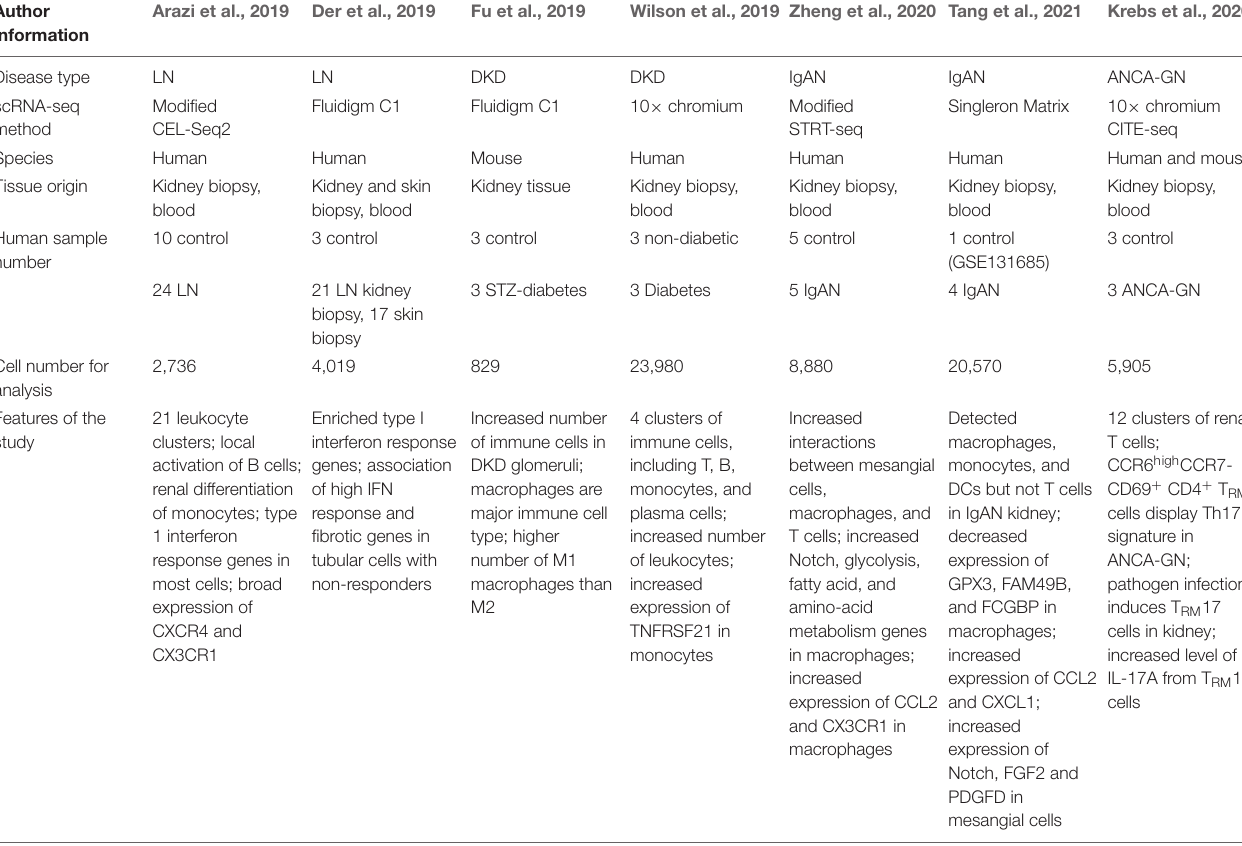
TABLE 2 | Summary of scRNA-seq in kidney